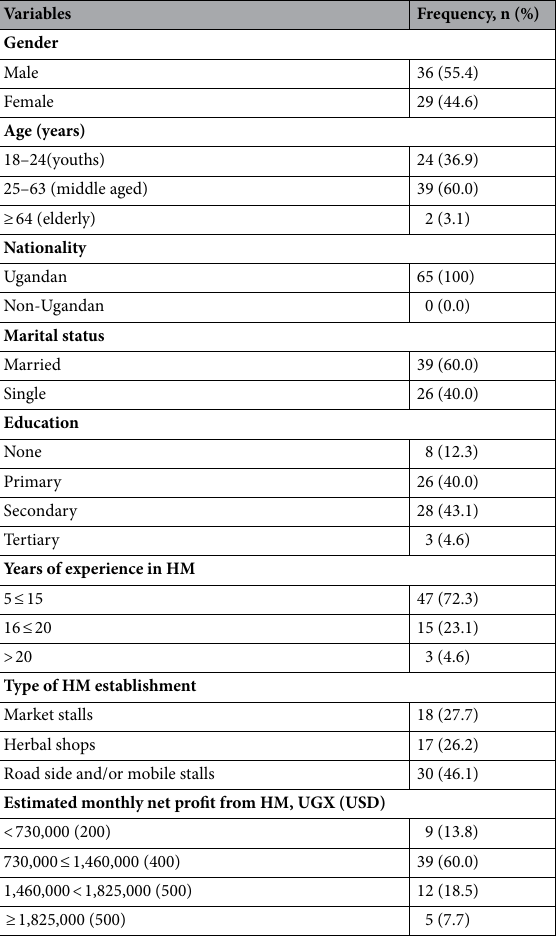
Table 1. Socio-demographic characteristics of commercial herbalists in Kampala city (N-65). UGX Uganda Shillings, $ United States Dollar, HM Herbal